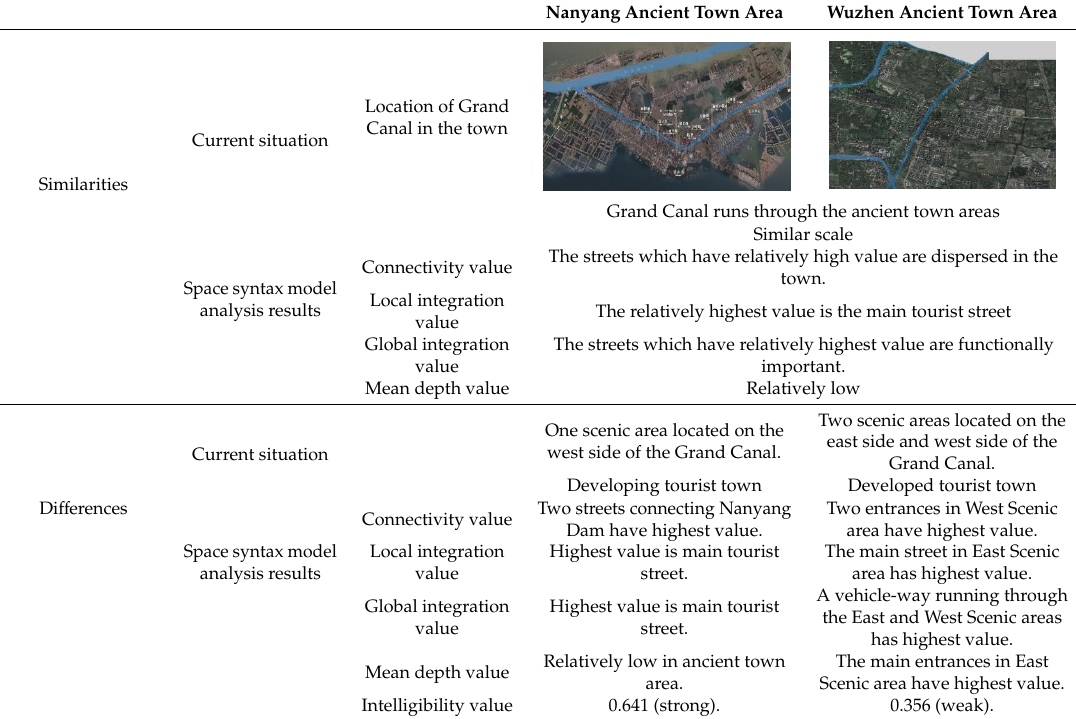
Table 5. Similarities and di ff erences of the Nanyang ancient town area and Wuzhen ancient town